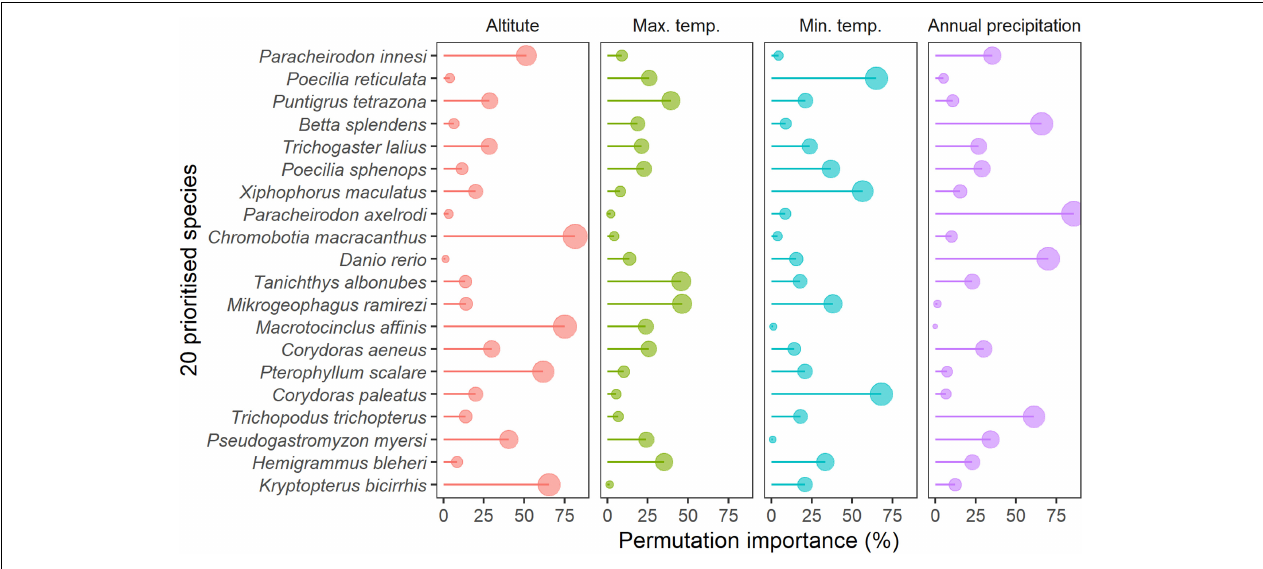
FIGURE 6 | Importance of climatic variables included in the species distribution (MaxEnt) models for the 20 prioritized aquatic ornamental species imported to New